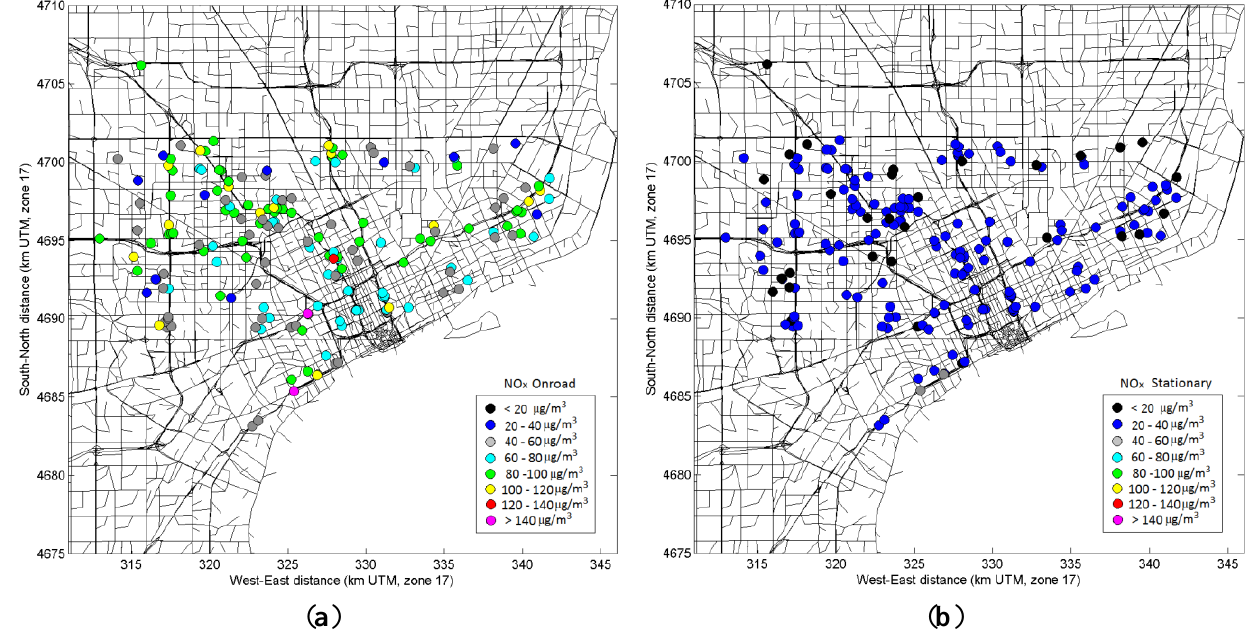
9. Spatial maps of modeled daily NO September-October 2010, showing contributions from mobile sources ( a ); stationary sources ( b ); urban background ( c ); and total ( d